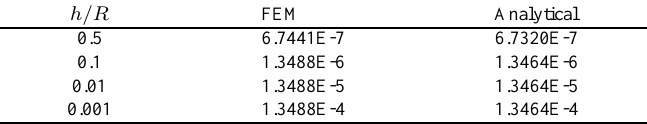
Table 2 FE predictions vs analytical solution for the tip deflection of cantilevered beam